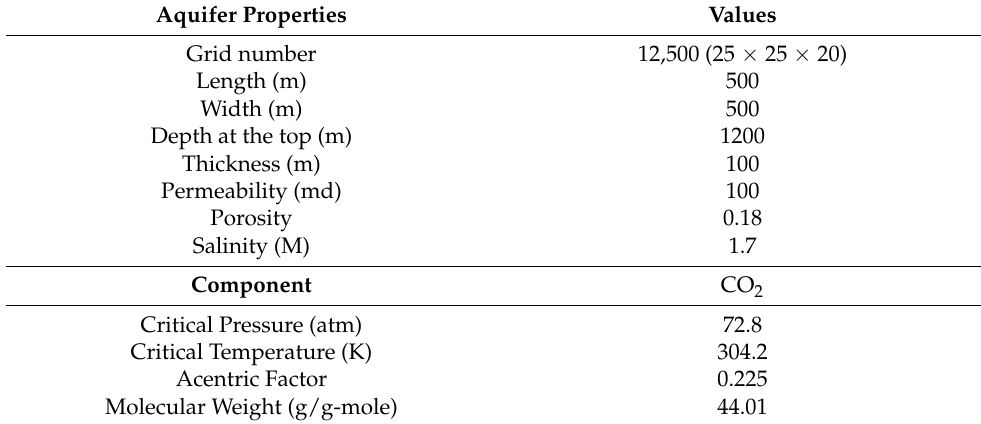
Figure 1. The 3D view ( left ) and the cross-section view ( right ) of the reservoir and the basic dimen- sions. The color scale shows the depth of the reservoir from the surface. Table 1. Saline aquifer system input